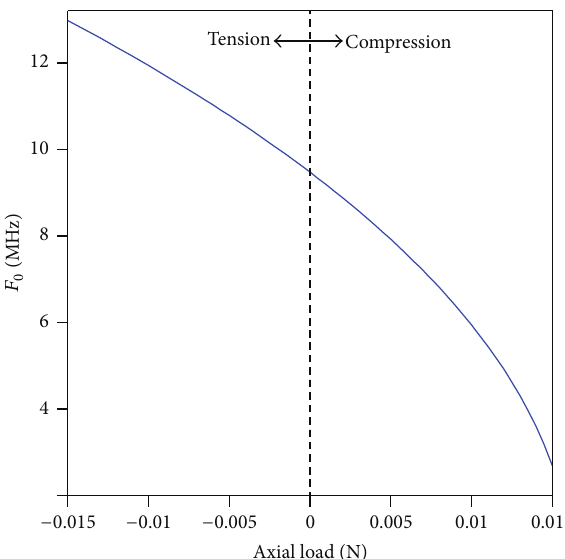
Figure 16: Variation of the center frequency of the unactuated filter with axial load in the primary beams.